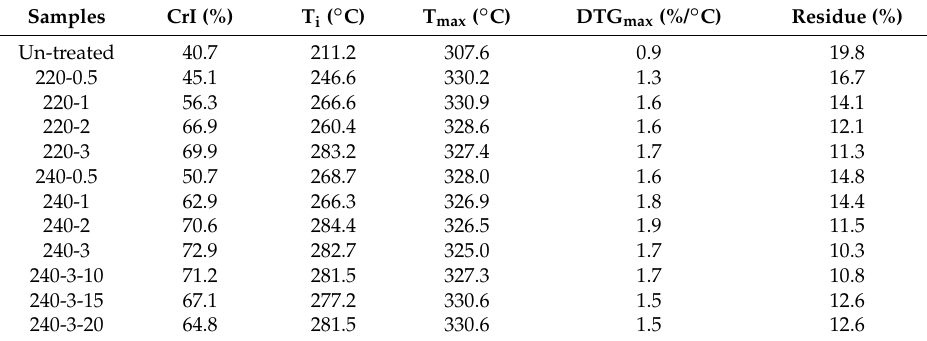
Table 5. Characteristic parameters of un-treated and glycerol pretreated corncobs. CrI: crystallinity index. Samples CrI (%)